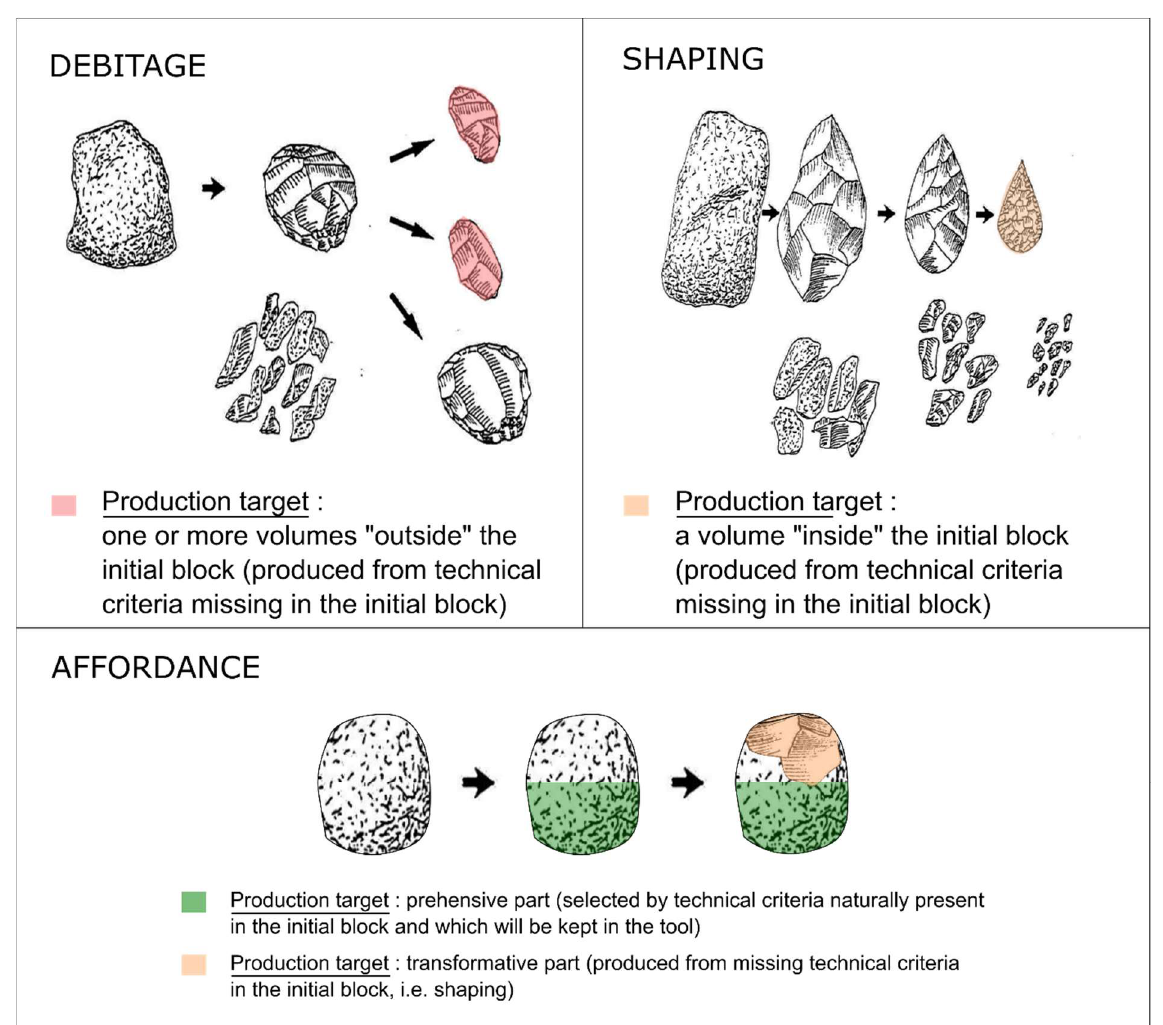
Figure 10. Three technical operations involved in lithic tool production (elaborated from Boëda 1997, fig.